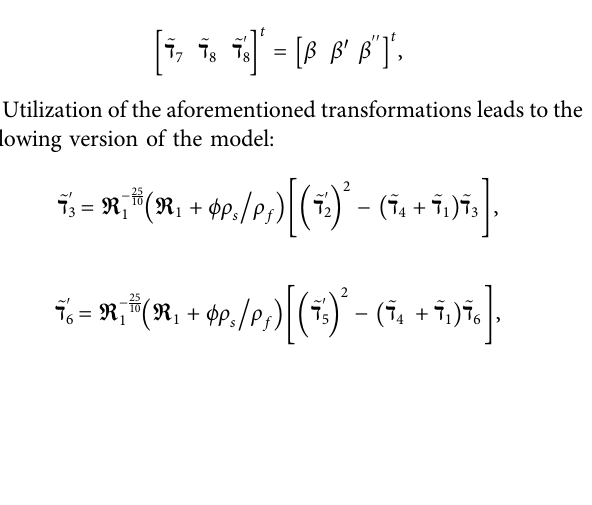
Frontiers in Energy Research |